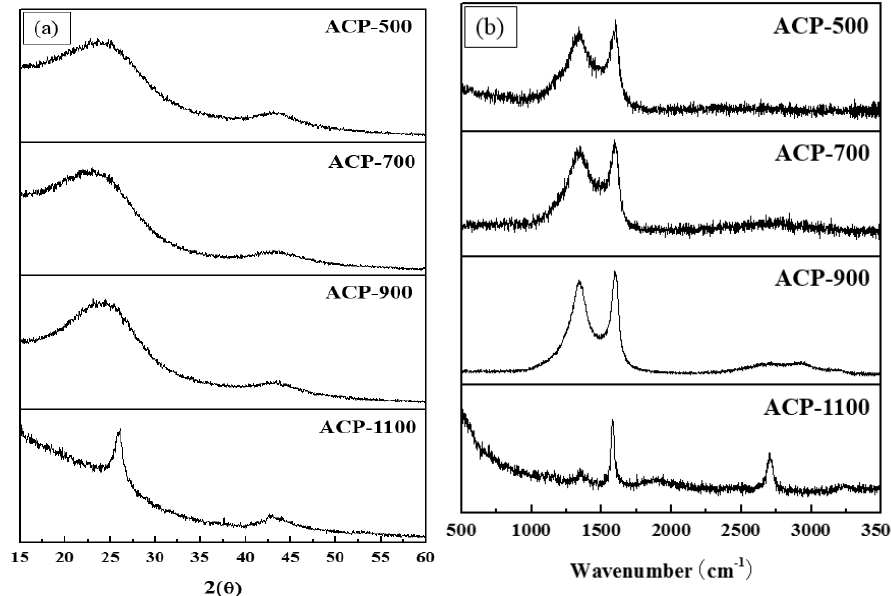
Figure 3. Crystal structure characterization: ( a ) XRD patterns and ( b ) Raman spectra of the ACPs.